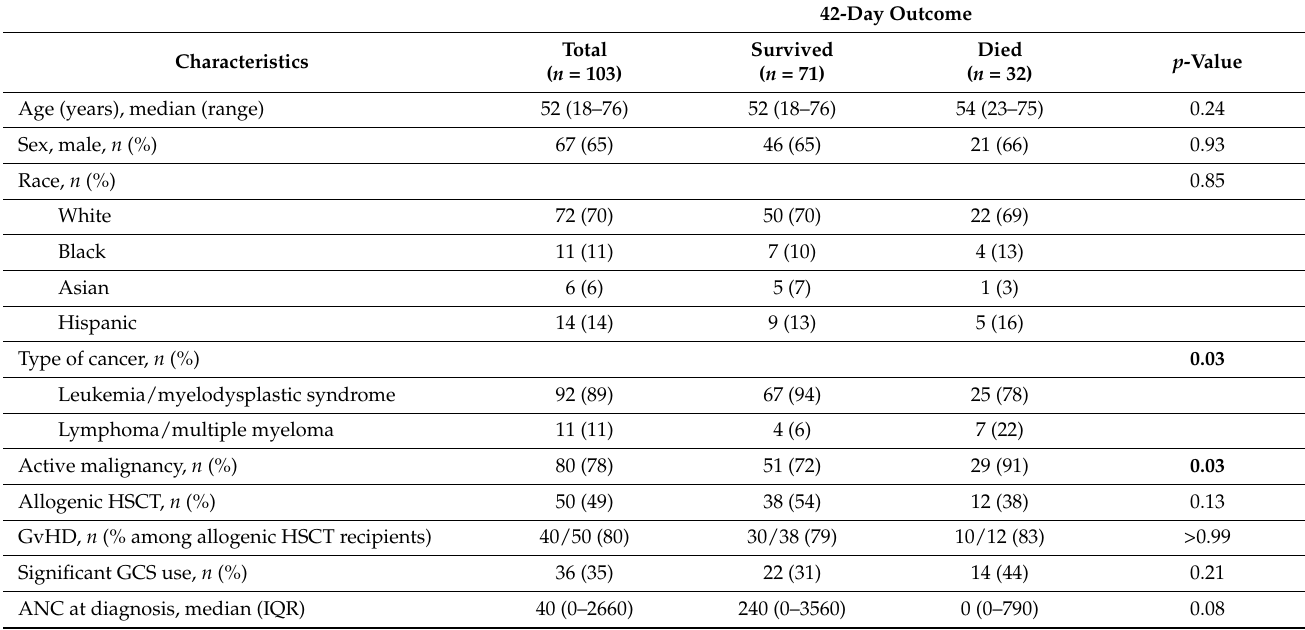
Table 1. Comparison of patients with MCR depending on 42-day outcomes from symptom onset. 42-Day